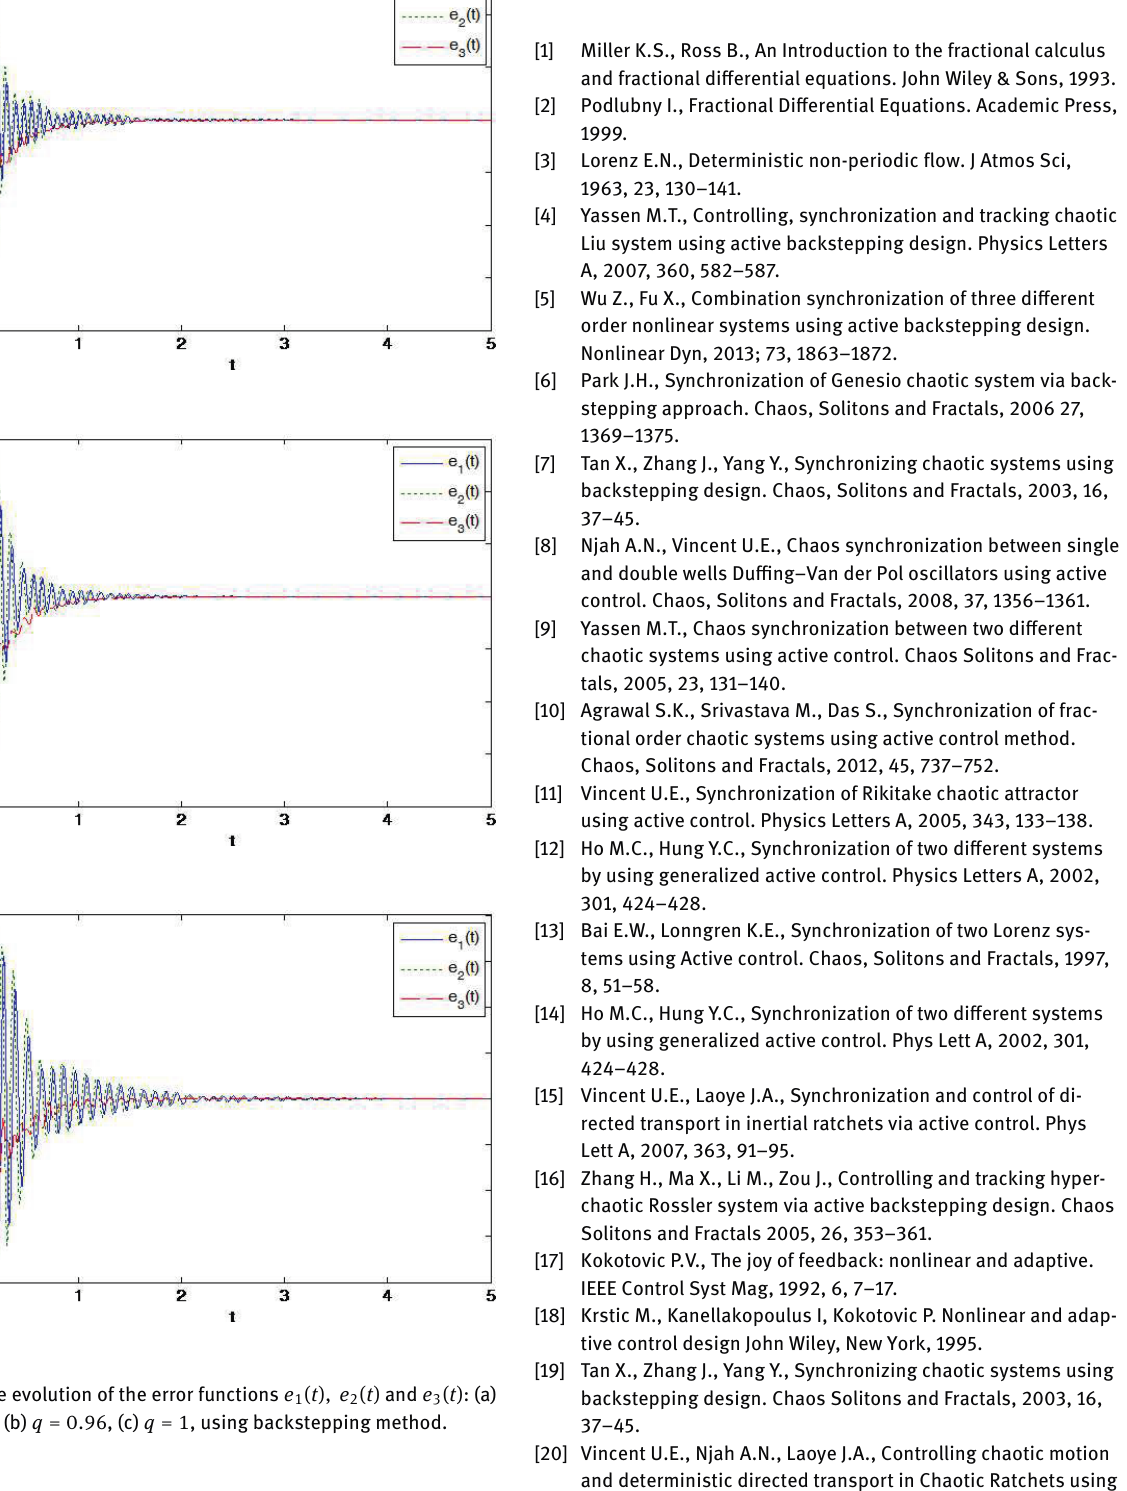
port from the UGC, New Delhi, India under the SRF-NET